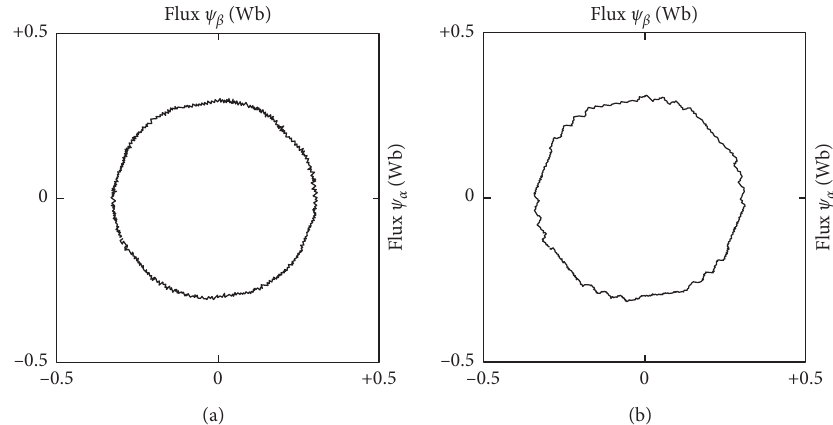
Figure 10: Flux locus simulation to observe the effect of the flux hysteresis band with (a) 2% and (b) 5% of the flux reference value.